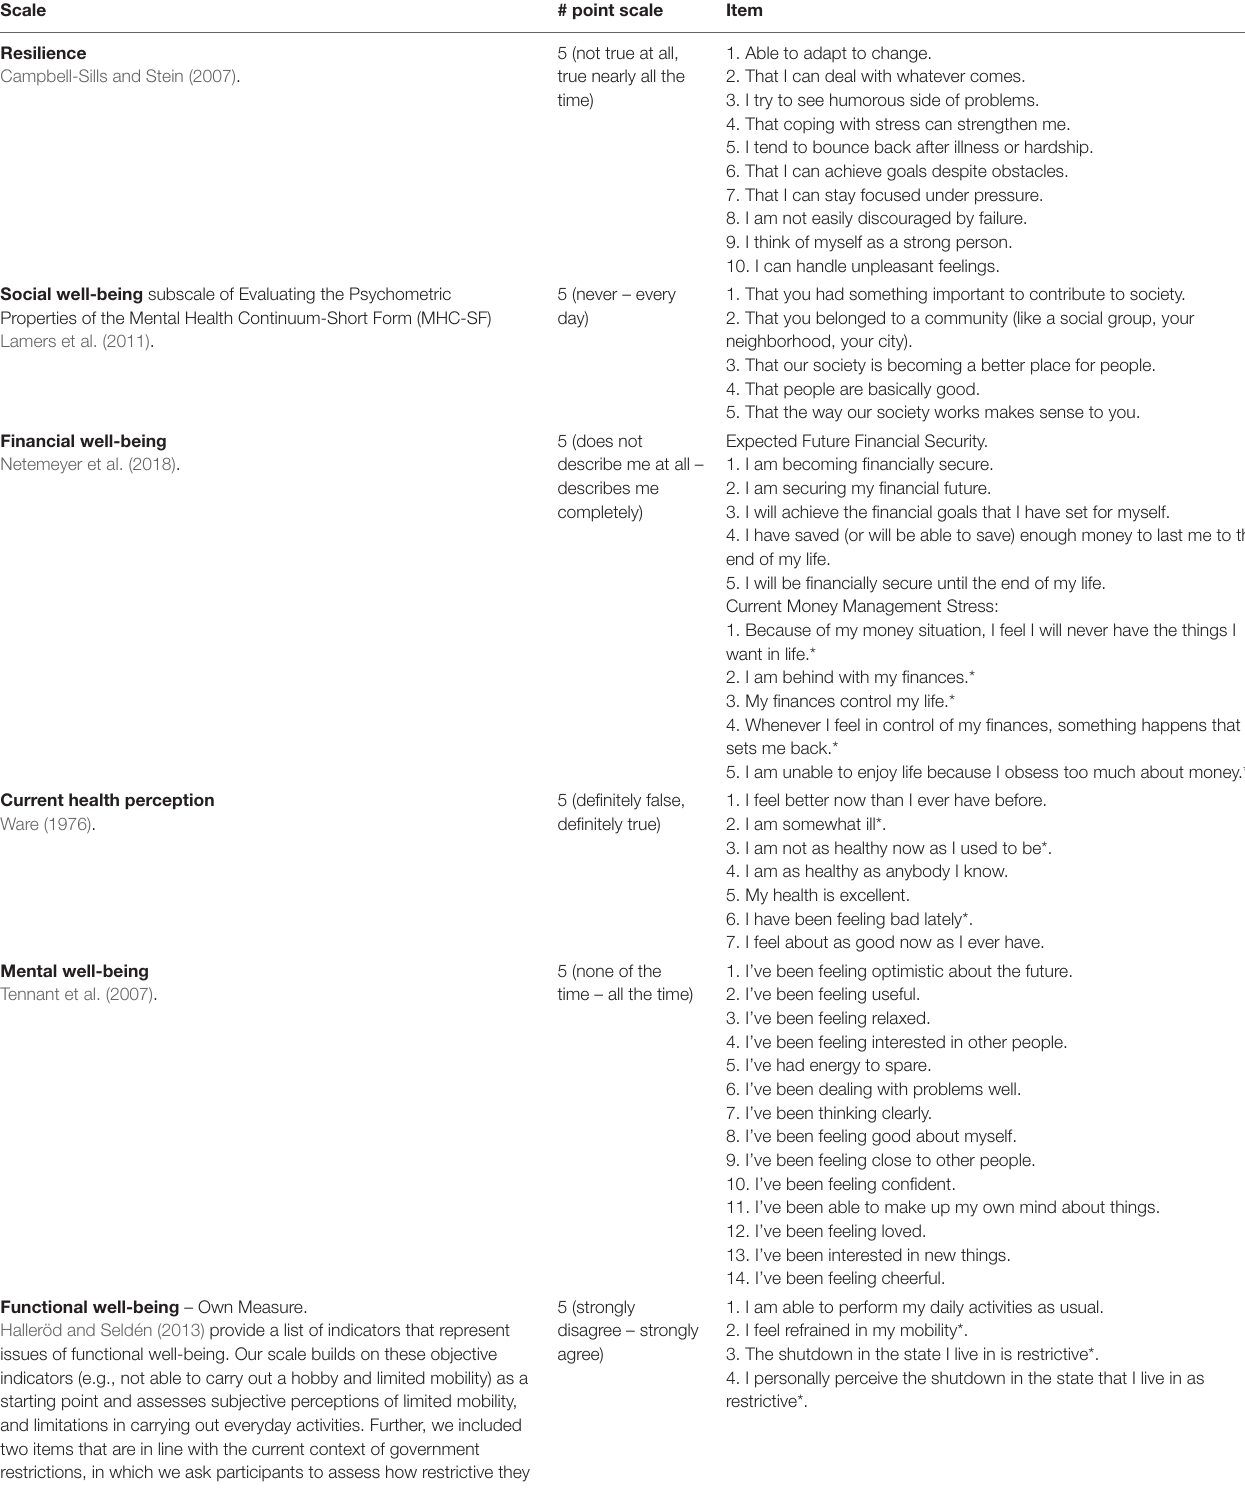
TABLE 3 | Overview of scales and items measured in survey. Scale # point scale Item Resilience Campbell-Sills and Stein